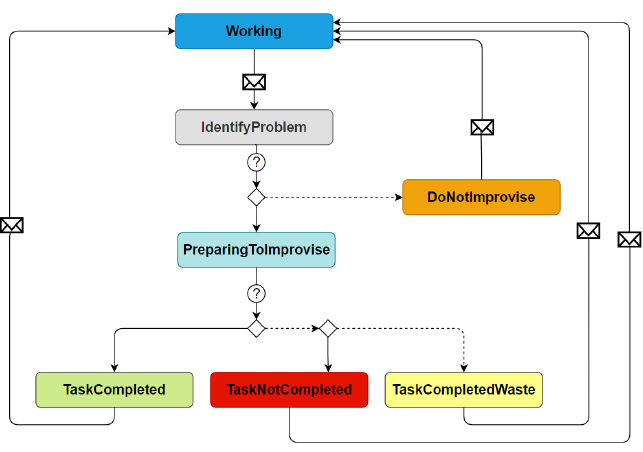
Figure 2. Behavioral states of an improviser.